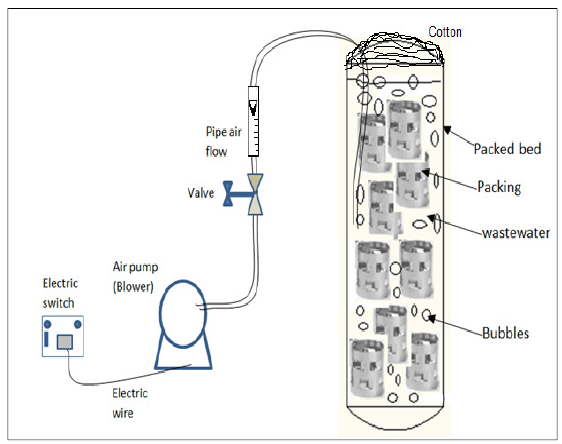
Fig. 1. Process flow diagram of the wastewater treatment by microalgae.